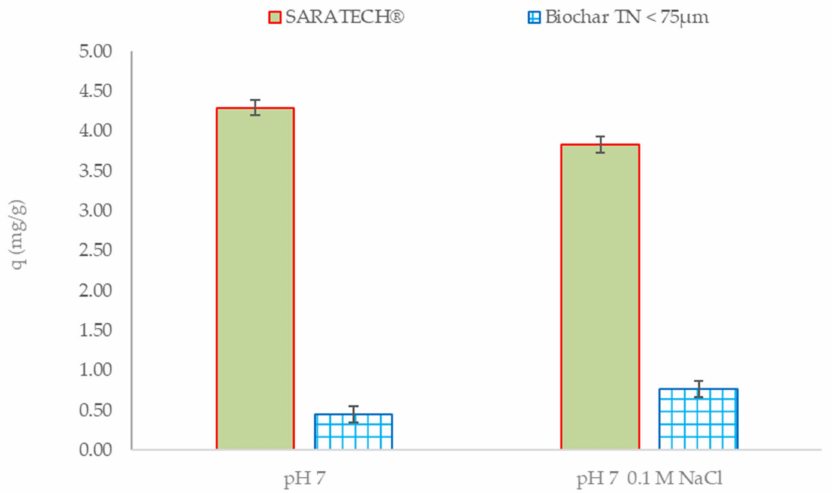
Figure 9. Effect of the electrolyte (0.1 M NaCl) on adsorption